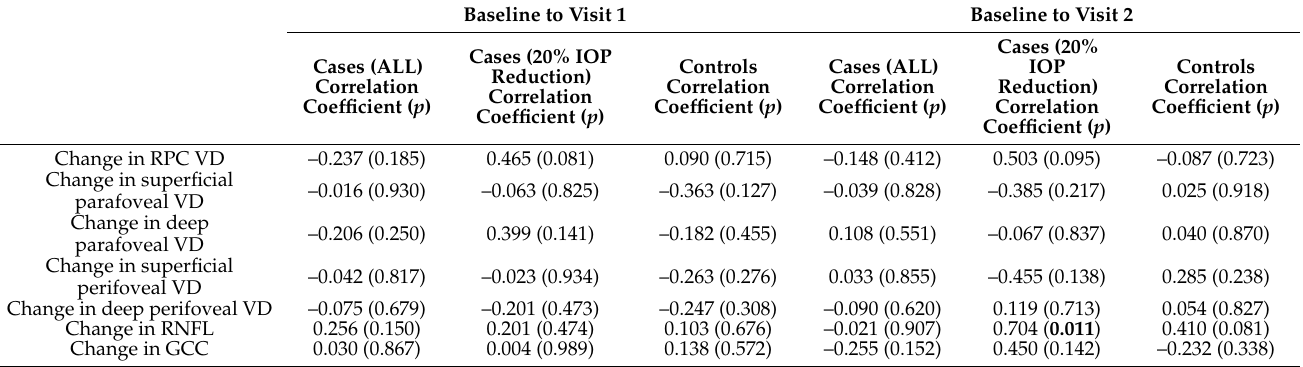
Table 4. Correlation of changes in intraocular pressure with changes in optical coherence tomography angiography